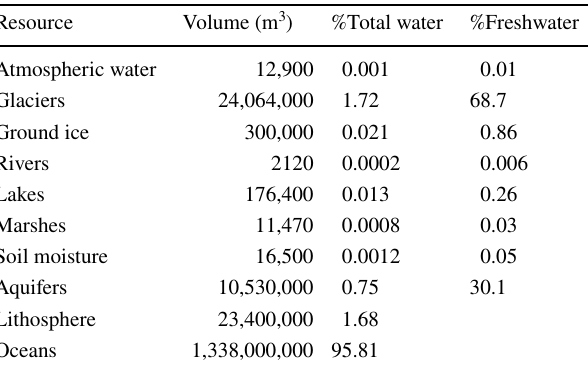
Table 1 Earth’s water budget